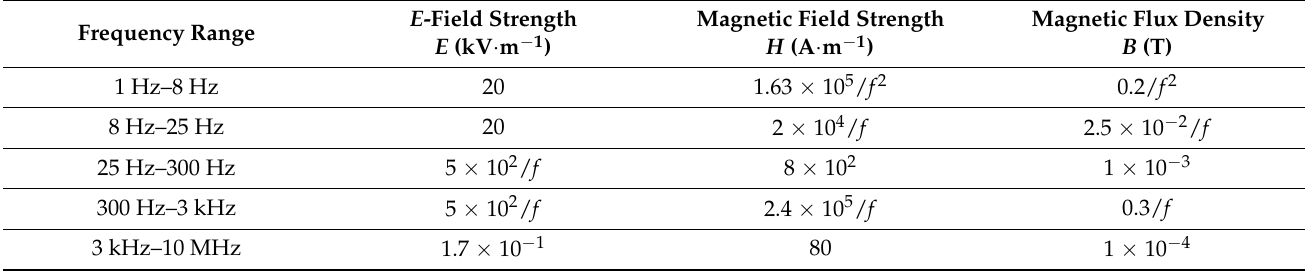
Table 1. Reference levels for occupational exposure to time varying electric and magnetic fields. Reprinted from ref. [70].